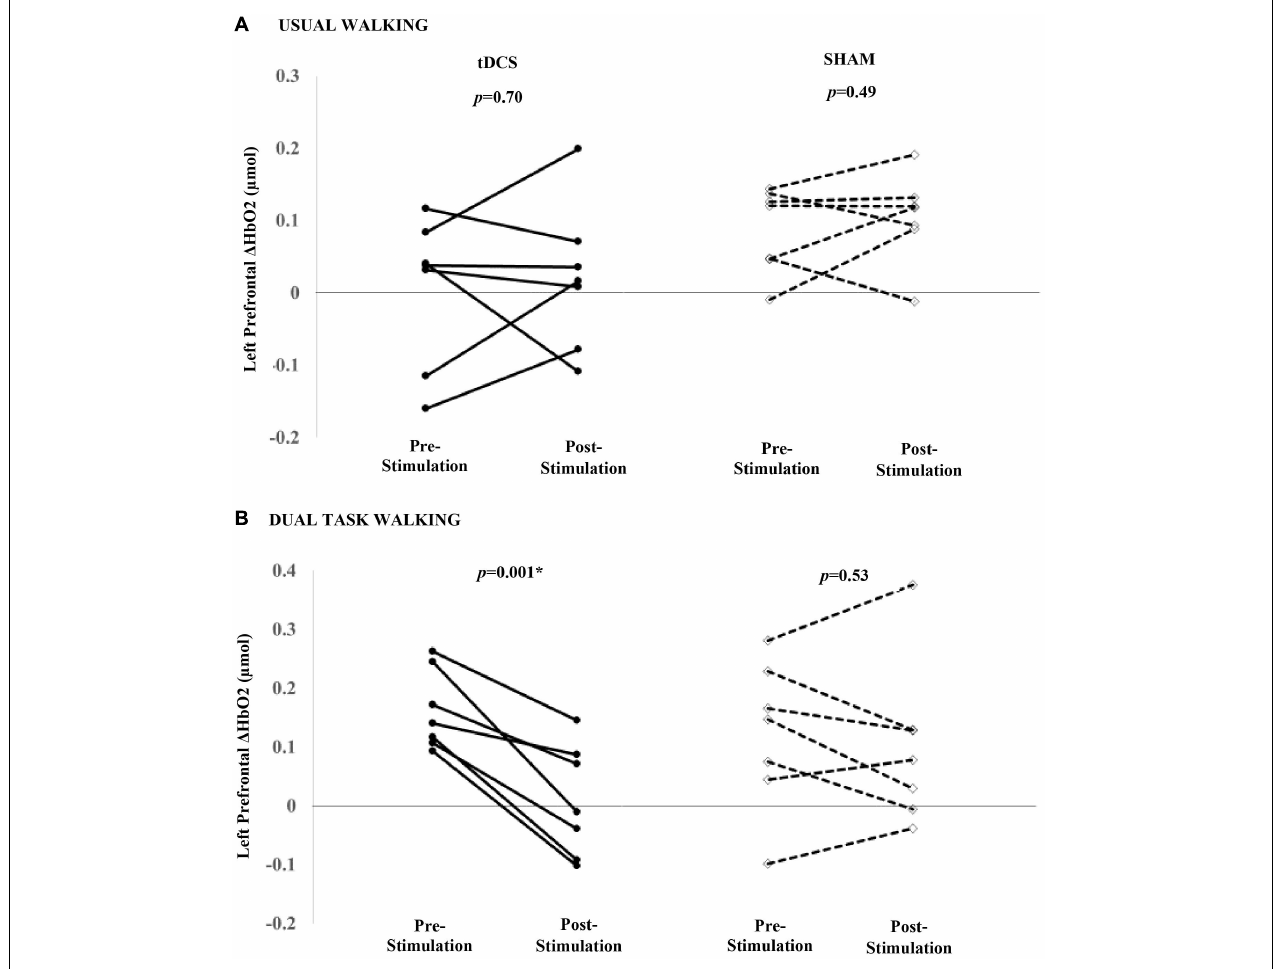
FIGURE 3 | Participant-level effects of a single session of tDCS or sham stimulation on the left prefrontal (cid:49) HbO2 during usual (A) and dual task walking (B) . tDCS nor sham was associated with a group-level change in left (cid:49) HbO2 during usual walking. tDCS was associated with reduced left prefrontal (cid:49) HbO2 during dual task walking. Seven of seven participants decreased left prefrontal (cid:49) HbO2 during dual task walking. Sham was not associated with a significant decrease in left (cid:49)